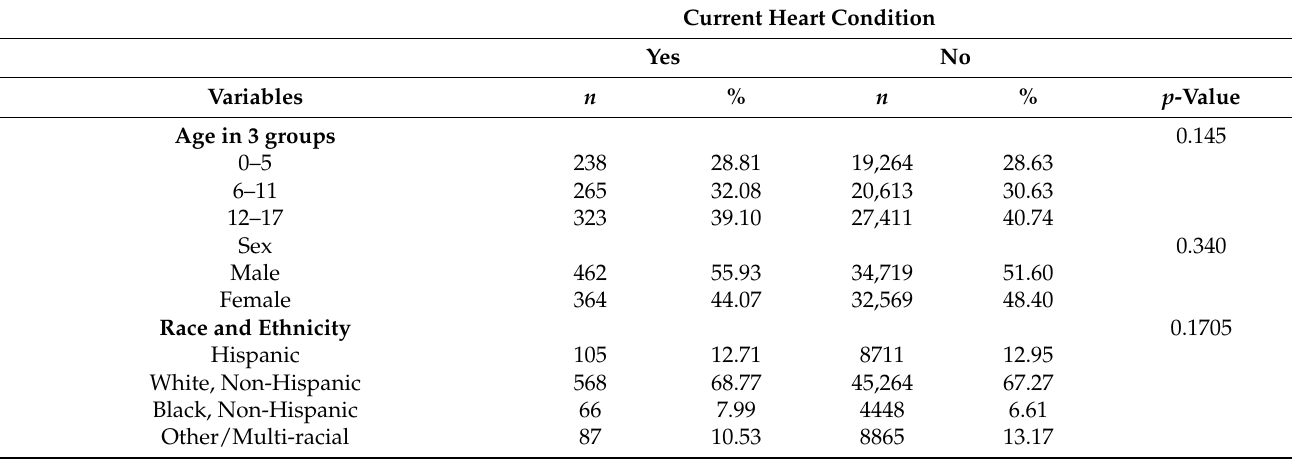
Table 1. Demographic characteristics of children with and without the heart conditions